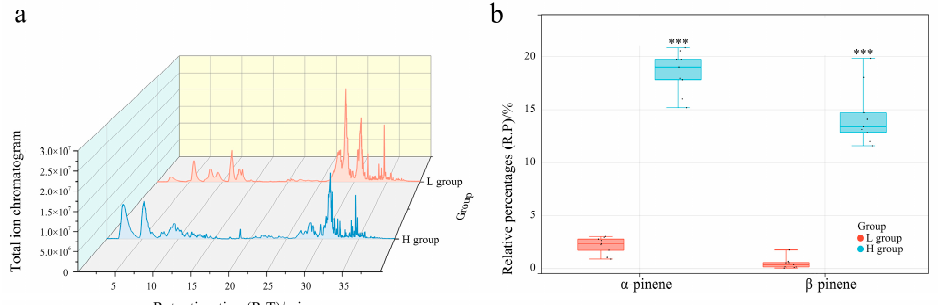
Figure 1. Comparison of phenotypic characteristics between L and H groups. ( a ) Total ion chromatogram of L and H group samples. ( b ) Comparison of α -pinene and β -pinene contents between L and H groups; *** p < 0.0001.